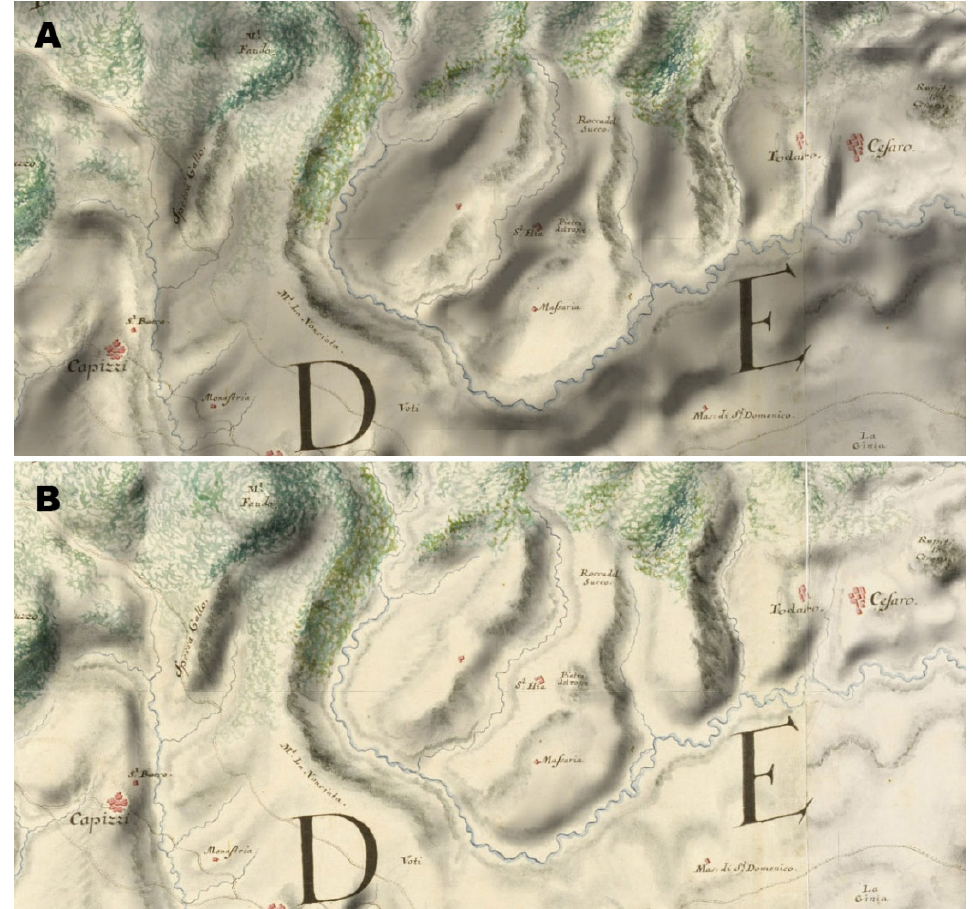
Figure 6. Juxtaposition of two opposite azimuths of illumination (Map of Sicily: ( A ): SE = 135° and ( B ): NW = 315°.